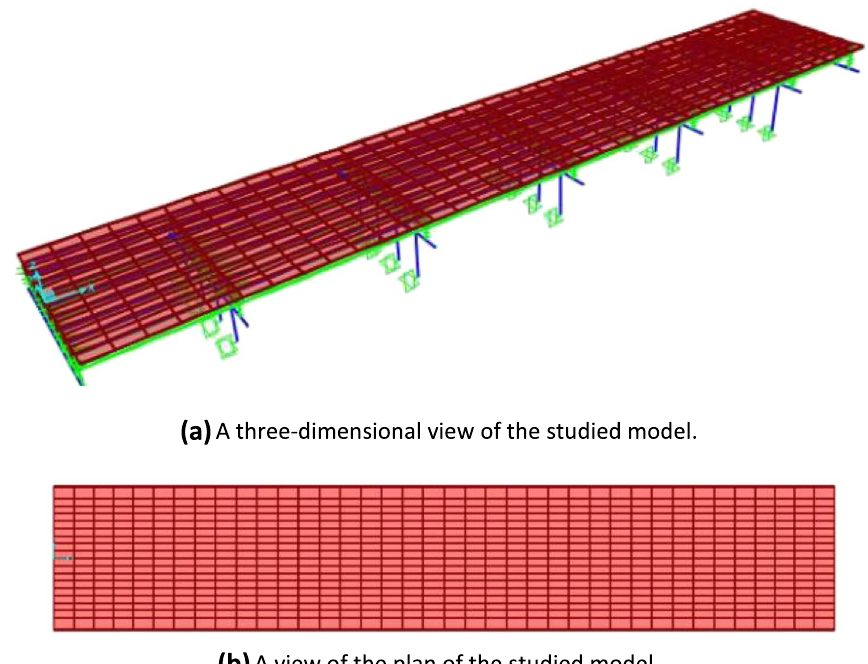
Fig. 2 The studied model of the RC bridge. a A three‑dimensional view of the studied model. b A view of